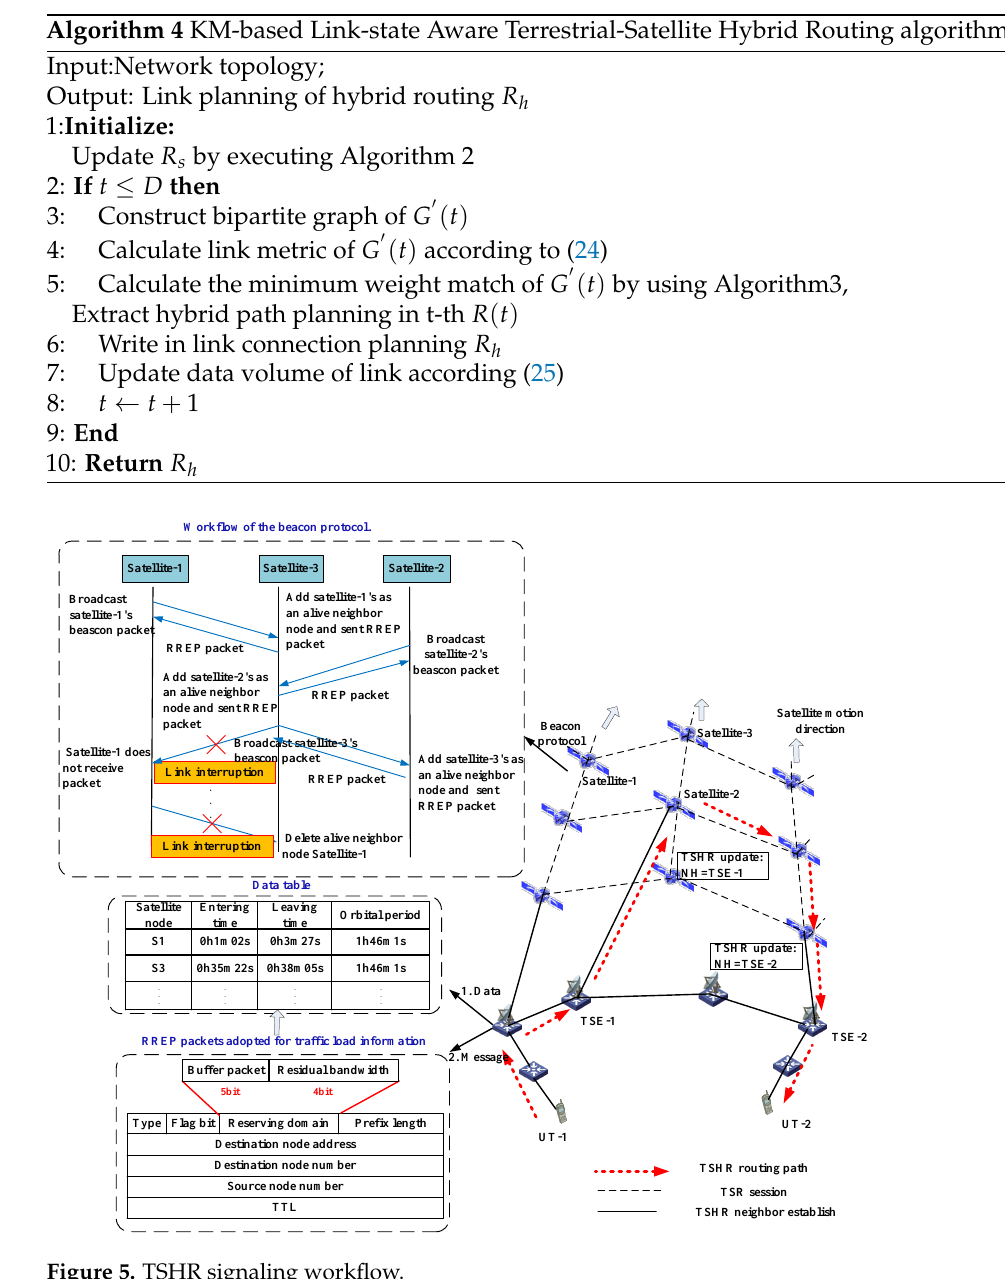
Figure 5. TSHR signaling